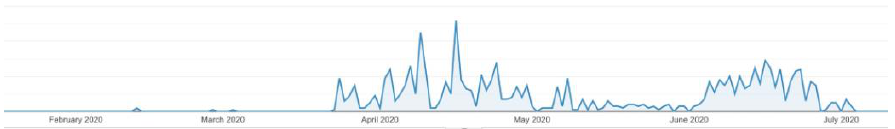
Fig. 7d. Dynamics of visits to the Definition of improper integral of the first kind (over an unlimited interval).